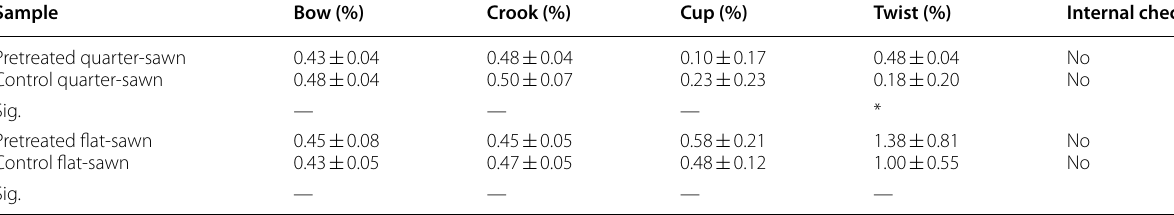
Table 4 Appearance quality of MW-pretreated and control samples after drying